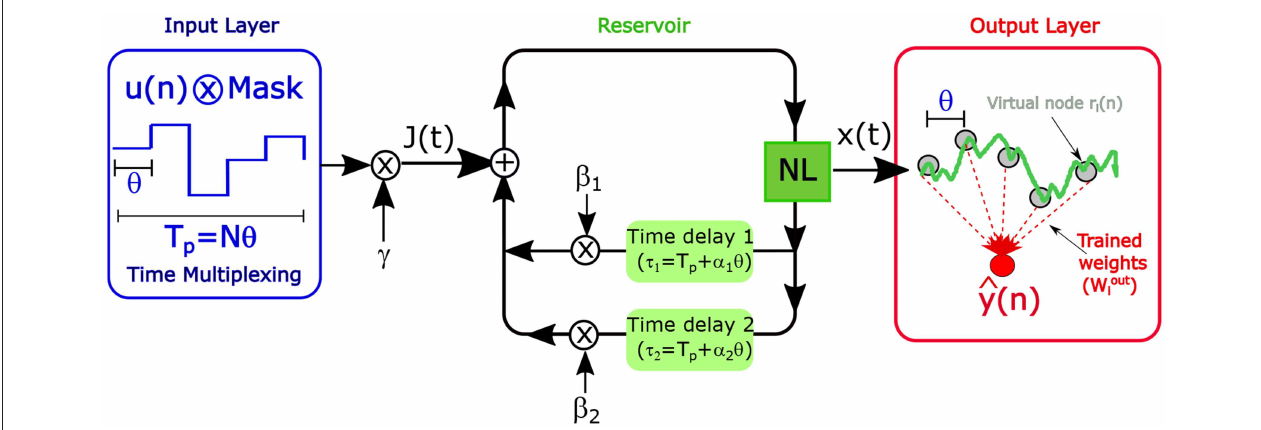
FIGURE 1 | Schematic illustration of delay-based RC. NL stands for Non-linear Node. The NL can have one ( β 2 = 0) or two delay lines. The points r i ( n ) represent the virtual nodes separated by time intervals θ . The masked input u ( n + 1) ⊗ Mask is injected directly following u ( n ) ⊗ Mask.